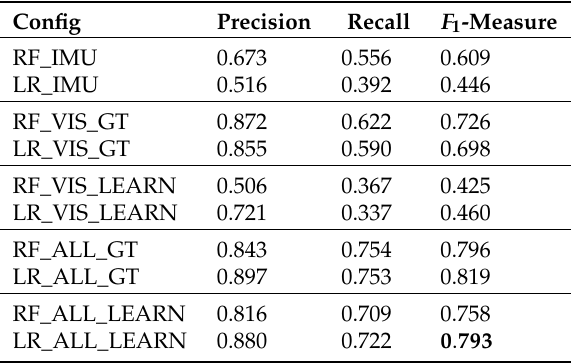
Table 2. Different configurations for our learning method. Values are reported as an average over all classes and for both subjects. RF = Random Forest, LR = Logistic Regression, ALL = both modalities were used, VIS = only vision features, IMU = only acceleration features, GT = ground truth vision, LEARN = vision features that were detected by our neural network. Config Recall F 1 -Measure